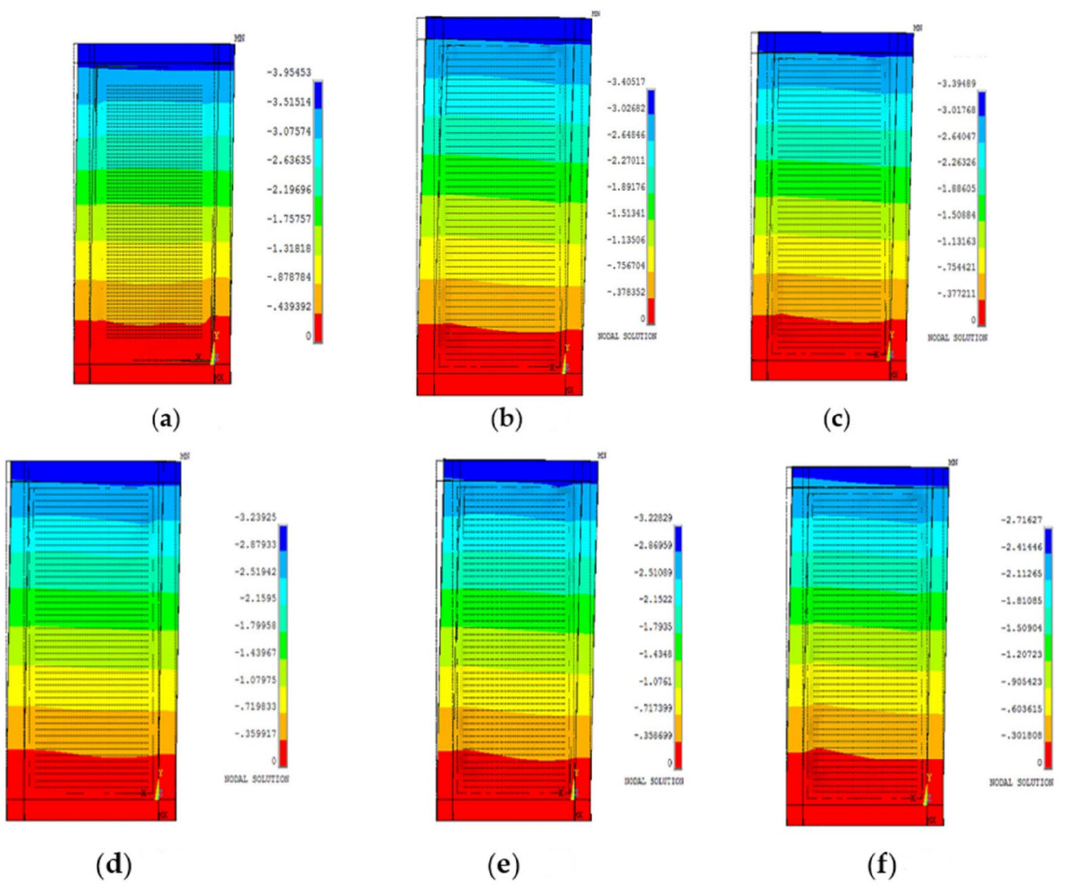
Figure 19. Effect of yield stress (YS) of infill steel plate on the lateral displacement, ( a ) YS = 150 MPa, ( b ) 200 MPa, ( c ) YS = 240 MPa, ( d ) YS = 300 MPa, ( e ) YS = 350 MPa, ( f ) YS = 380 MPa 2.